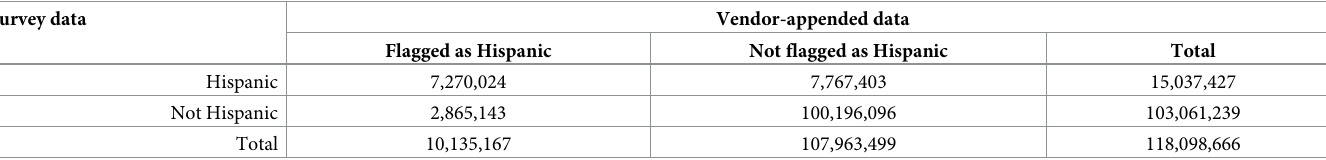
Table 3. Example of weighted household counts used to compute concordance of ethnicity data between vendor-appended frame data and survey data. Survey